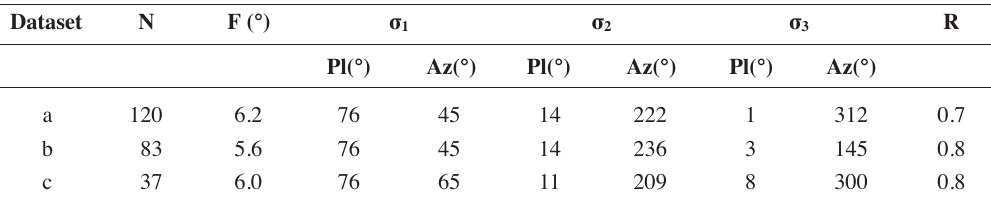
Table III. Results from Stress Inversion Runs. N, F and R are, respectively, the number of events, the average misfit corresponding to the stress solution found and the measure of relative stress magnitude. Deviatoric prin- cipal stress axes, σ 1 , σ 2 , σ 3 , are the compressional, intermediate and extensional deviatoric axes, respectively. They are specified by plunges measured from horizontal and azimuth measured clockwise from north. For the corresponding dataset, see the